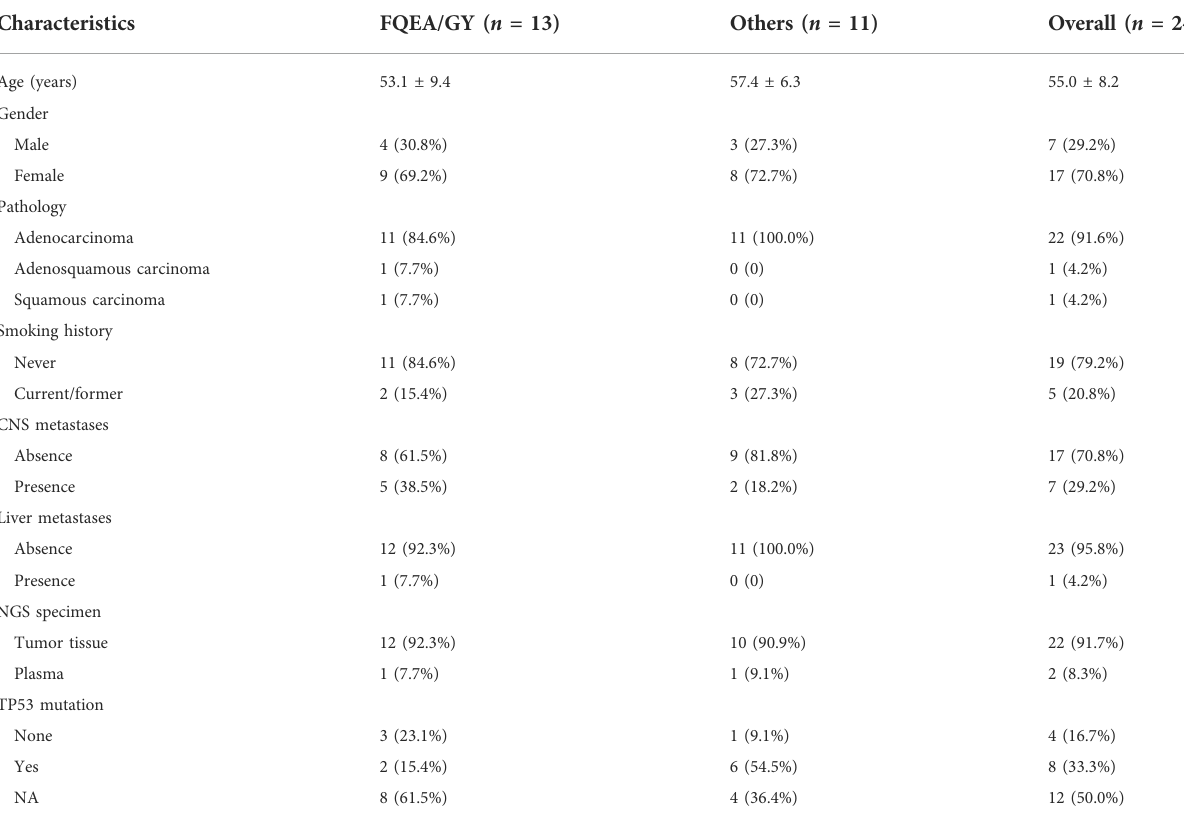
TABLE 1 Clinicopathological characteristics of NSCLC patients with EGFR exon 20 insertions treated with fi rst-line targeted therapy.